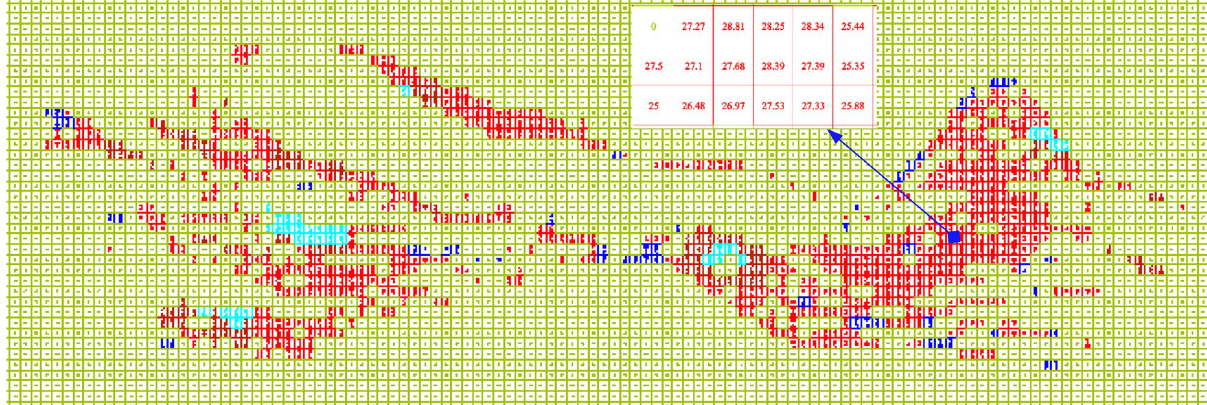
Figure 3. Grade distribution at − 172